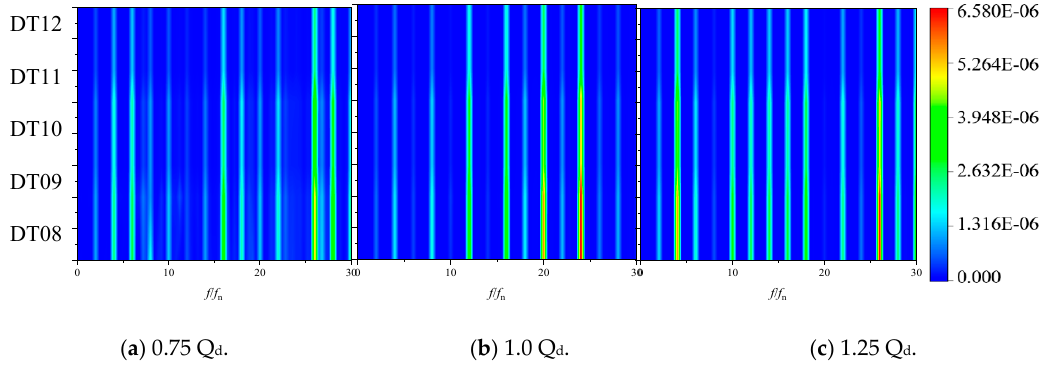
Figure 26. Frequency domain of pressure fluctuation of DT04–DT12.